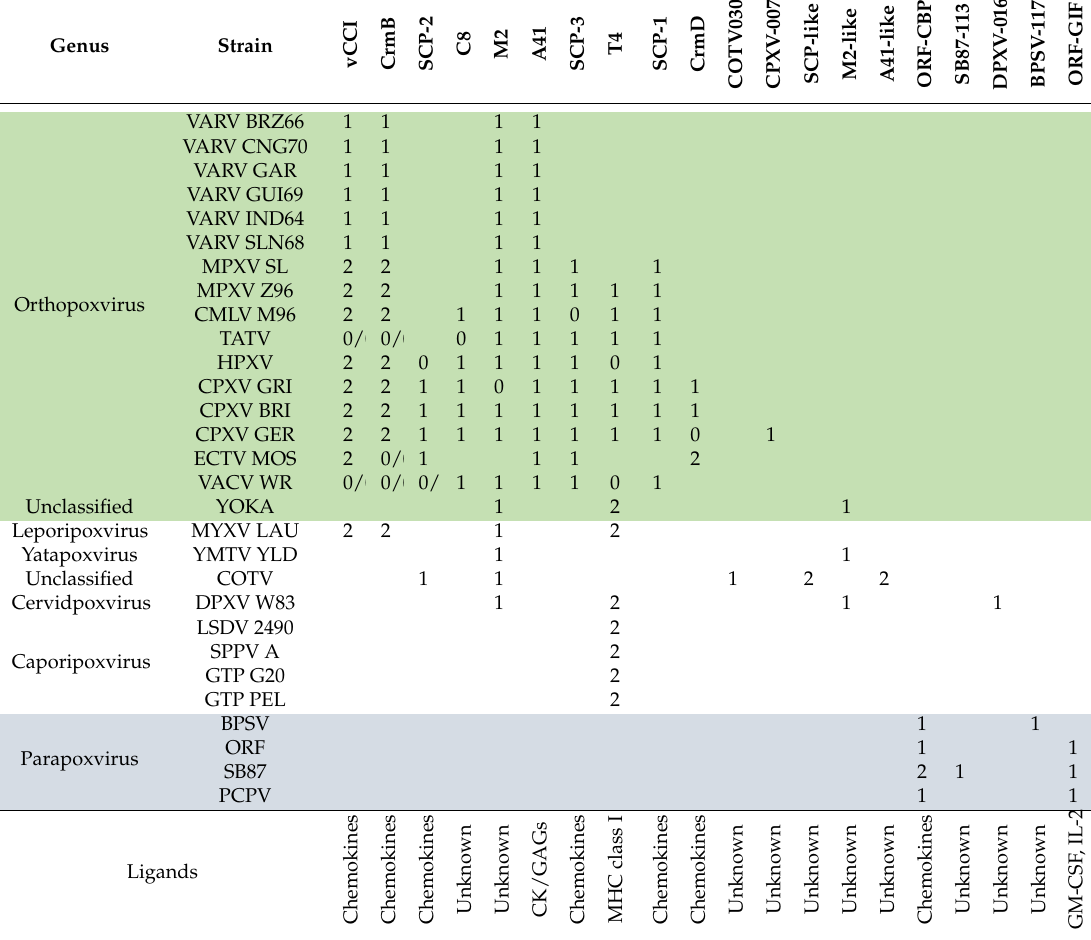
Table 2. Distribution of PIE and Putative PIE